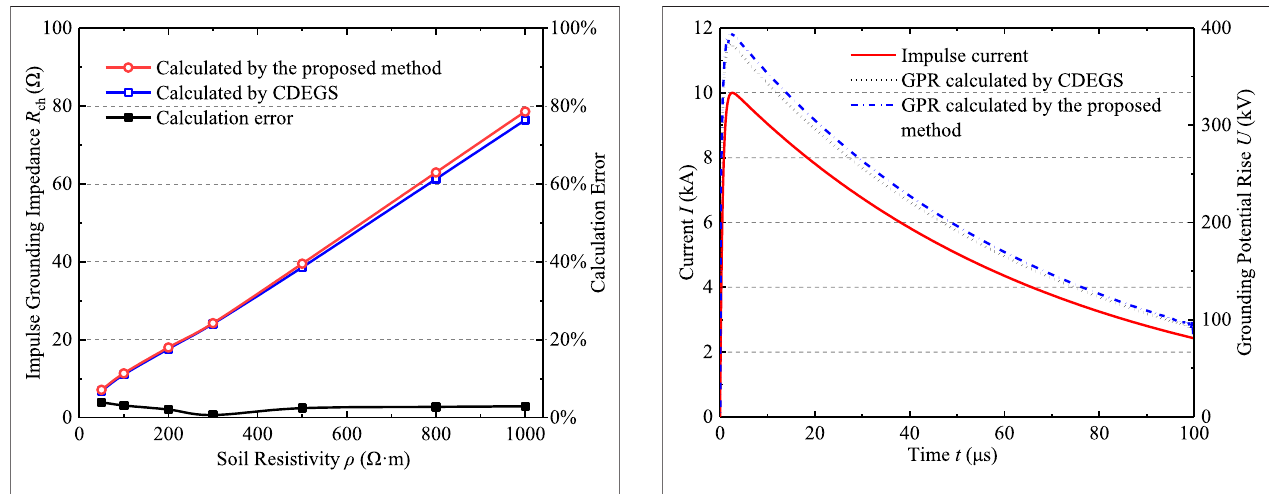
FIGURE 4 | Impulse grounding impedance curve without considering spark discharge effect.